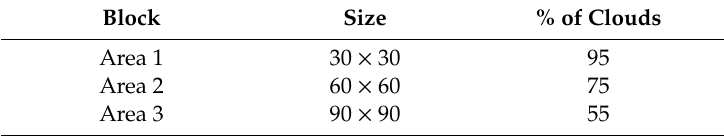
Table 3. Size and percentage of cloud pixels comprised by each